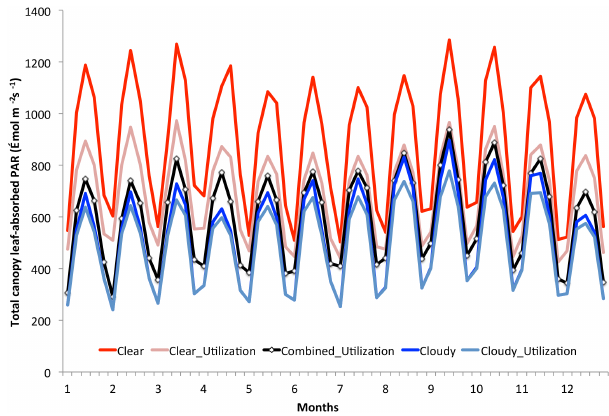
Figure 4. Cloudy (blue) and clear-sky DART simulations (red) were corrected for light saturations effects. Combined results (black line) are a weighted average of light utilization estimates from clear and cloudy simulations for 5h per day and 1 day per month.